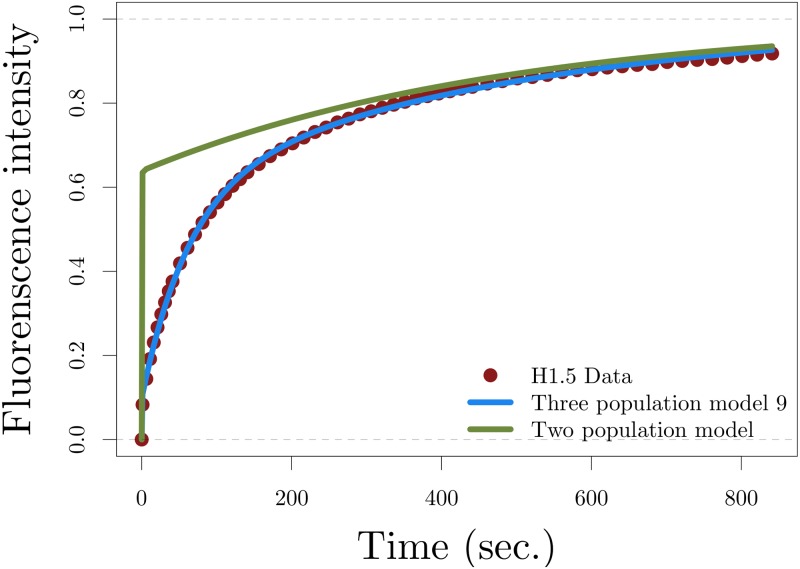
Validating the three population model.Fitting the three-population model to histone H1.5 data (blue) and sketch of the solution of the approximated two population model given by Eq (4) with the parameter values in Eq (6) (green).